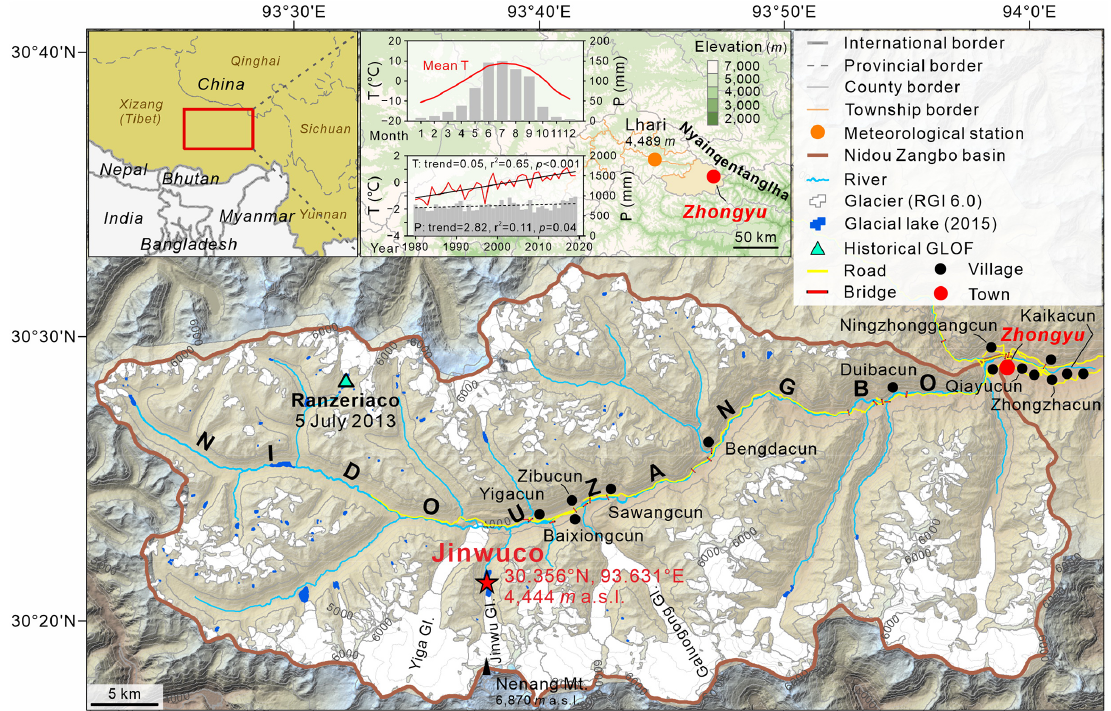
Figure 1. Location of Jinwuco and surrounding geographic features, including terrain, rivers, glaciers, glacial lakes, settlements, and major infrastructures (roads and bridges) downstream. The climate statistics in the upper middle panel are based on the Lhari weather station, approx. 50km away from Jinwuco, 1980–2019. The topographic base map is based on the DEM generated from Ziyuan-3 stereoscopic pairs. The borders and location of the villages are from © Baidu